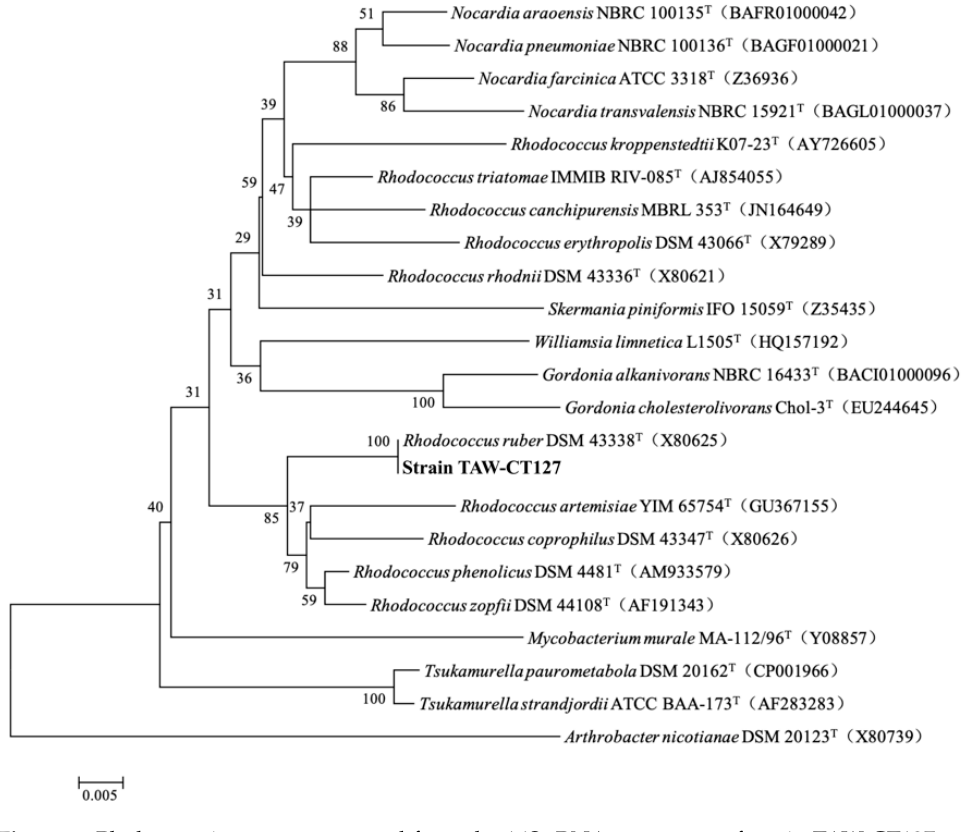
Figure 3. Phylogenetic trees constructed from the 16S rRNA sequences of strain TAW-CT127 and some other strains by the neighbor-joining method. The bold captions are the strain in this study .